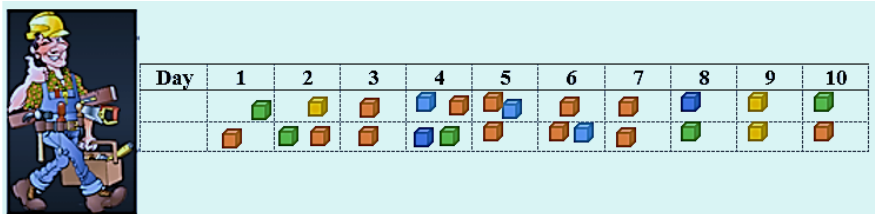
Figure 4. Results of task scheduling for each technician in each day.